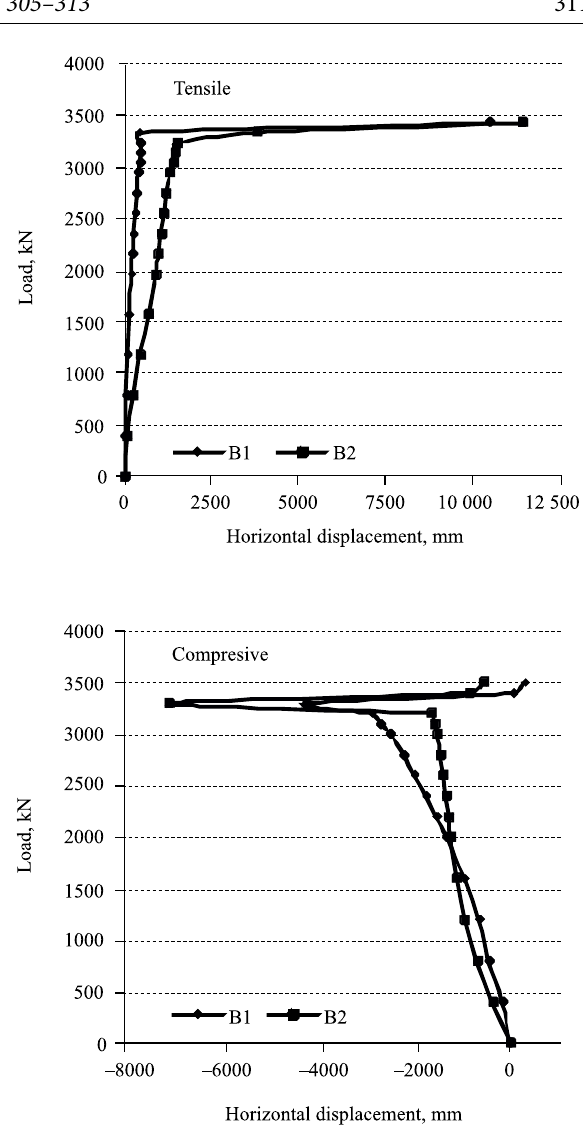
Fig. 12. Web member strain test results